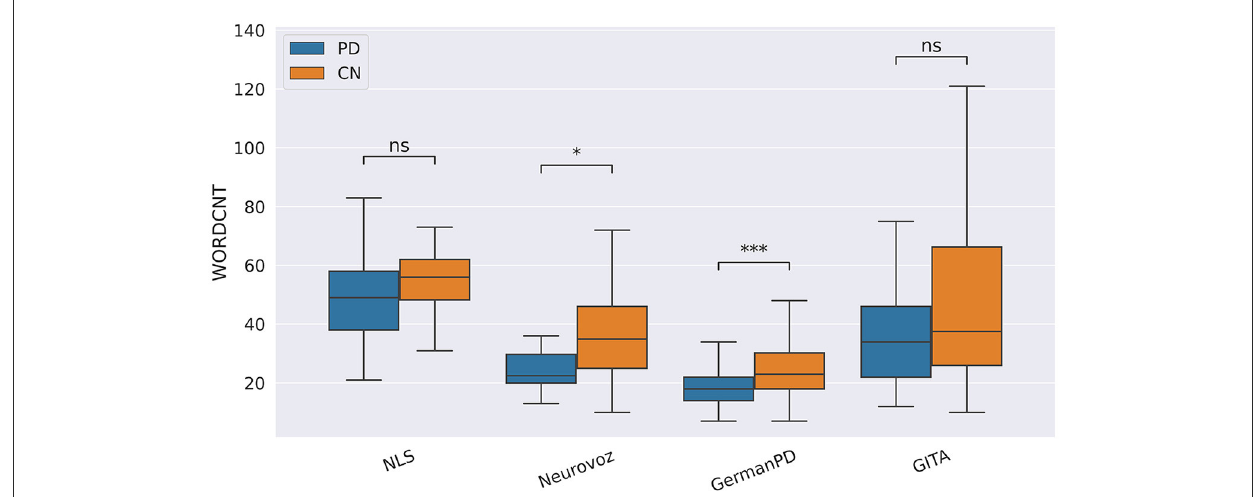
FIGURE3 Boxplots with statistical annotations representing the word count (WORDCNT) on NLS, Neurovoz, GermanPD, and GITA from the SS task. Horizontal lines represent the median, the top ends represent the upper quartile, and the bottom ends represent the lower quartile. Statistically significant differences between groups after Benjamini–Hochberg correction for WORDCNT are reported in Table 6 and highlighted below using asterisks. WORDCNT, word count; CN, controls; PD, Parkinson’s disease; SS, spontaneous speech; ns, not significant.